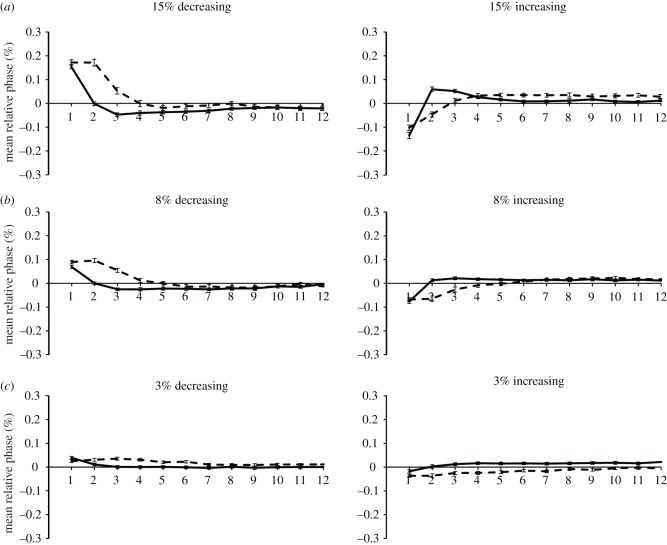
Mean relative phase values for control participants by perturbation type (solid lines represent phase and dashed lines, period), direction, amount and sequence position following perturbation.